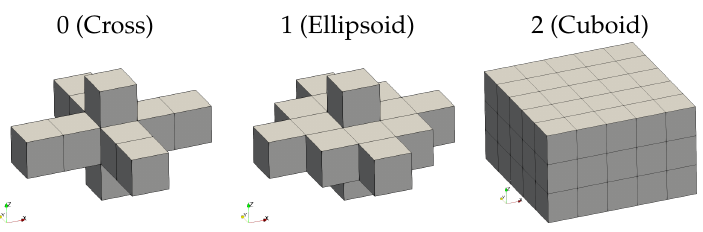
Figure 3. Savitzky–Golay filter windows of different shapes assuming a size equal to